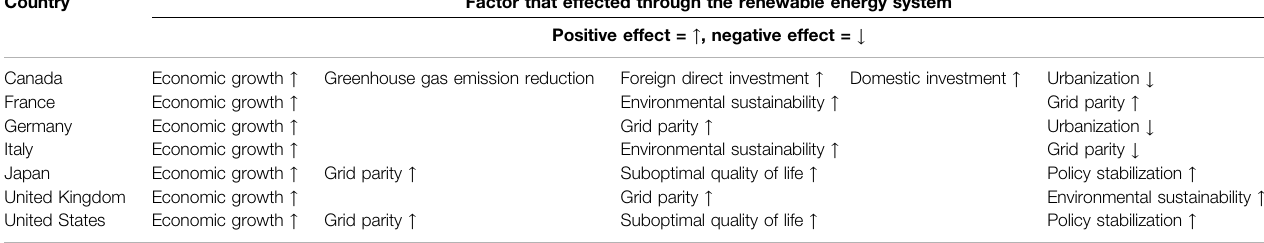
TABLE 2 | Factor that effected through the renewable energy